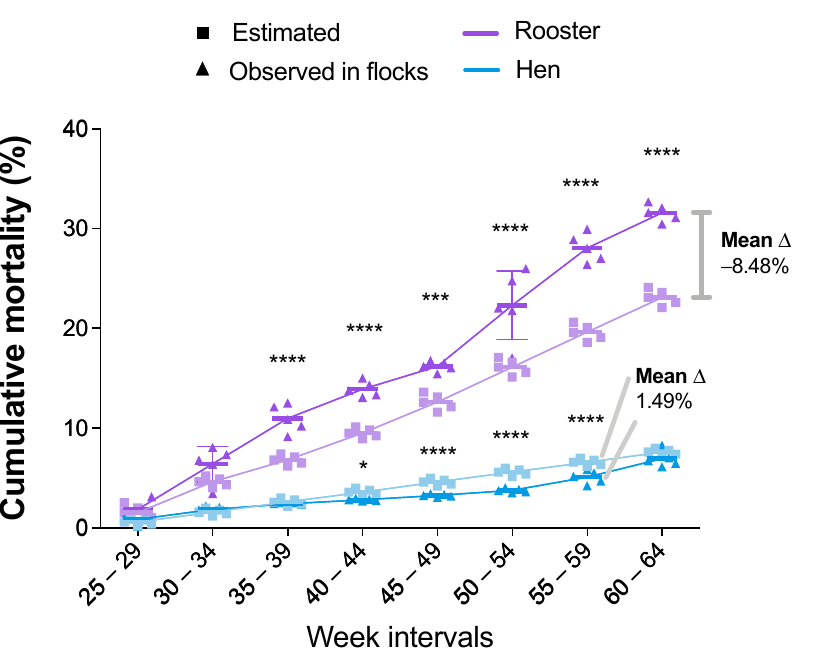
Figure 5. Percentages of cumulative rooster mortality (CRM) and cumulative hen mortality (CHM) for estimated and observed flocks. Results are presented as mean and standard deviation, and mean differences (shown as delta “ ∆ ” mean) were calculated subtracting observed from estimated values. Comparisons were performed using the two-way ANOVA test followed by the Bonferroni correction post-hoc test. * p < 0.05; ** p < 0.005; *** p < 0.0005; **** p < 0.0001.